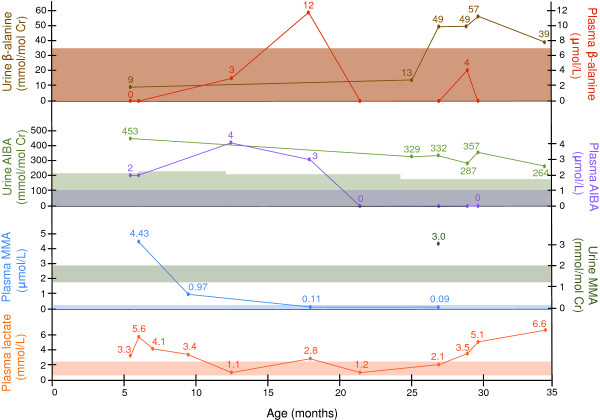
Chronological outline of select investigations, with fluctuating levels over time. The variability is independent of dietary modifications or pharmacological treatment. Normal ranges are represented by shaded areas. AIBA: 3-aminoisobutyric acid.